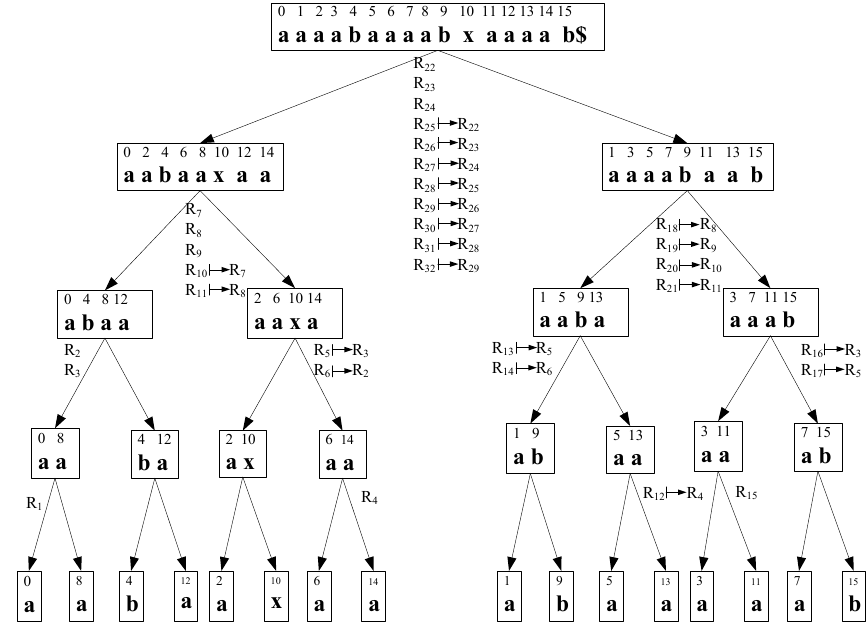
Figure 2. Conflict tree for the example sequence T = aaaabaaaabxaaaab . The original sequence is indicated at the root node. The notation R is resolved by R after a certain number of steps, given that R j pairs are labeled following a depth-first traversal on the